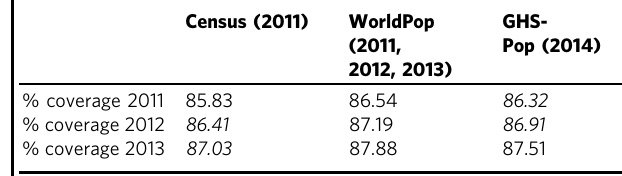
Table 2 Population coverage percentages in each year for three different population distribution datasets.